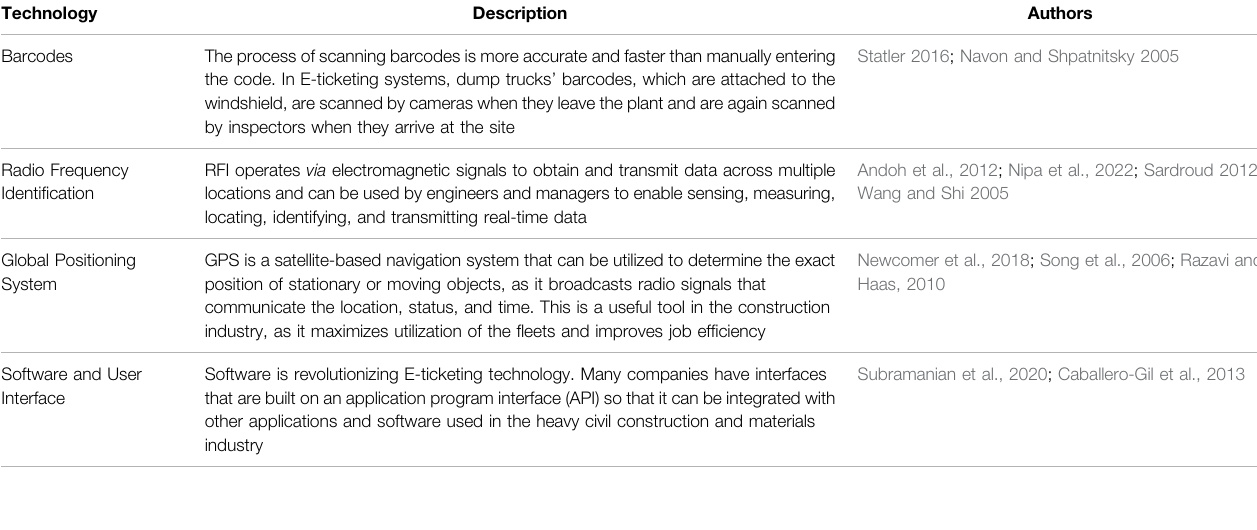
TABLE 2 | Key technologies used in E-ticketing systems.